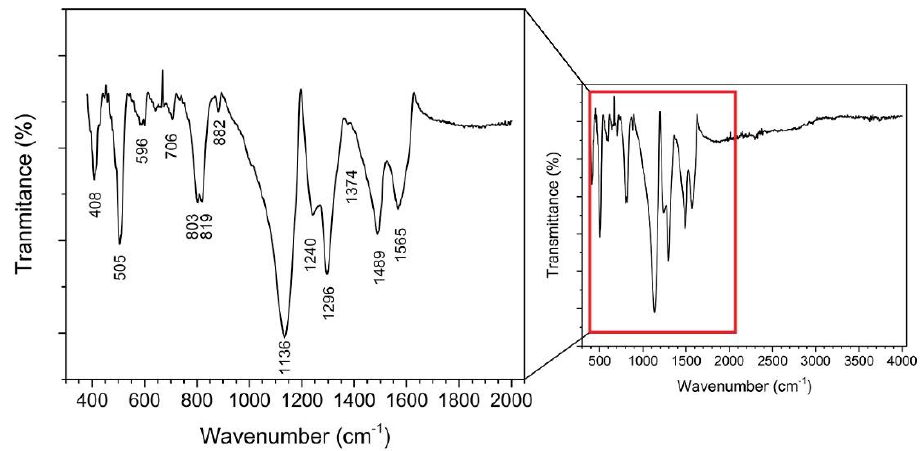
Figure 6. Fourier-transform infrared (FTIR) spectrum of PANI-Au-SPE with magnified fingerprint (500–1500 cm −1 ) and double bond (1500–2000 cm −1 ) region.